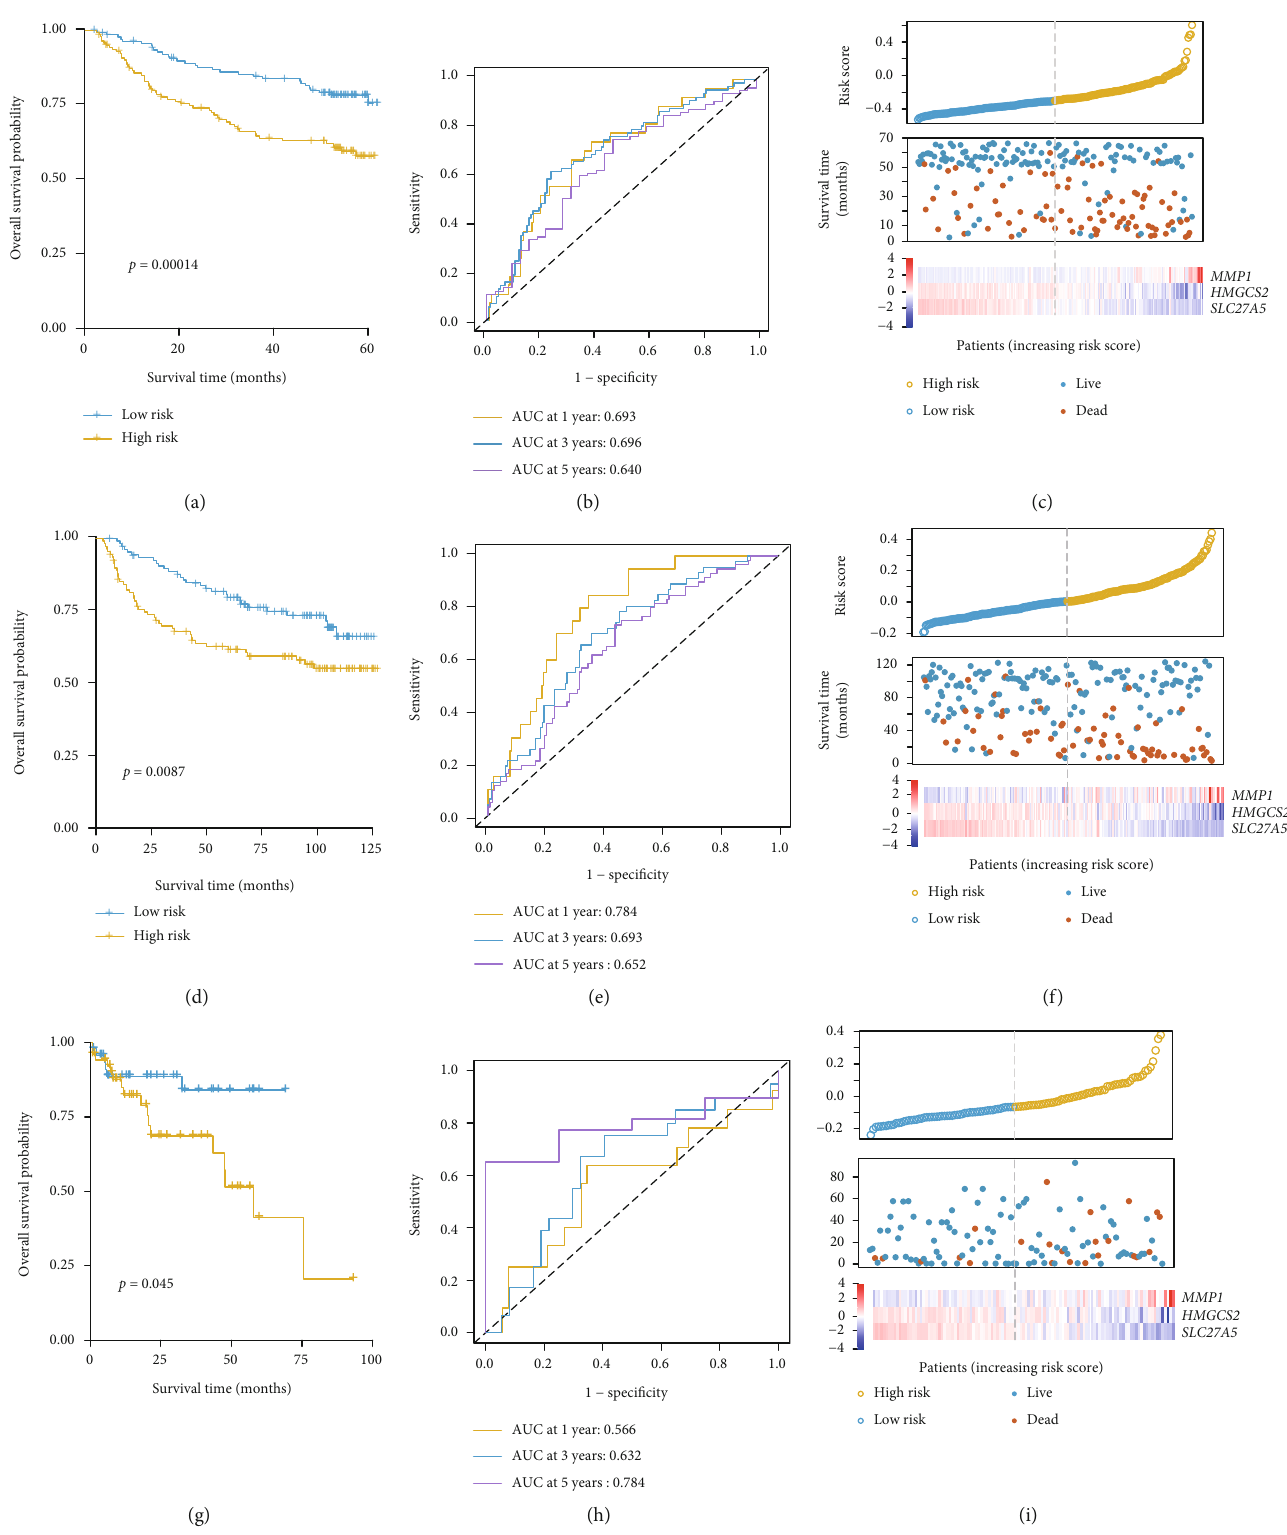
Figure 4: Prognostic model validation. The prognostic e ffi cacy of this model was assessed with the GSE14520 (a – c), GSE36376 (d – f), and GSE76427 (g – i) veri fi cation